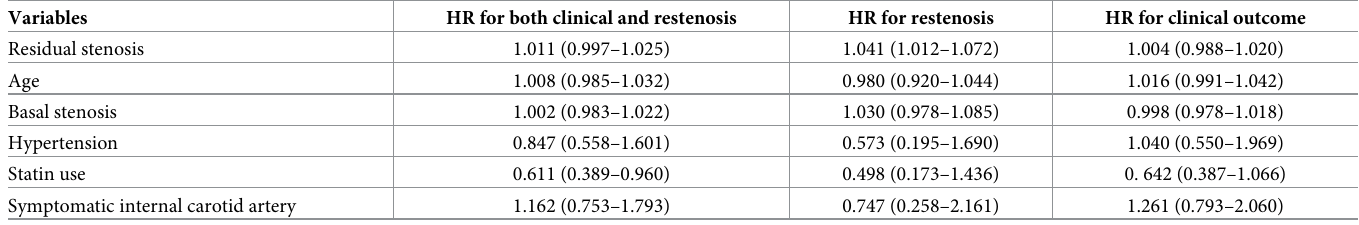
Values were adjusted hazard ratio (95% confidence interval) obtained from Wei-Lin-Weissfeld (WLW) models. HR was abbreviated for hazard ratio. The model fit of global model was R 2 = 0.012 and likelihood ratio test (LR test) = 9.71 (P = 0.1). The model fit of each-event model was R 2 = 0.03, and LR test = 12.51 (P = 0.05) for restenosis and R 2 = 0.018, and LR test = 7.47 (P =